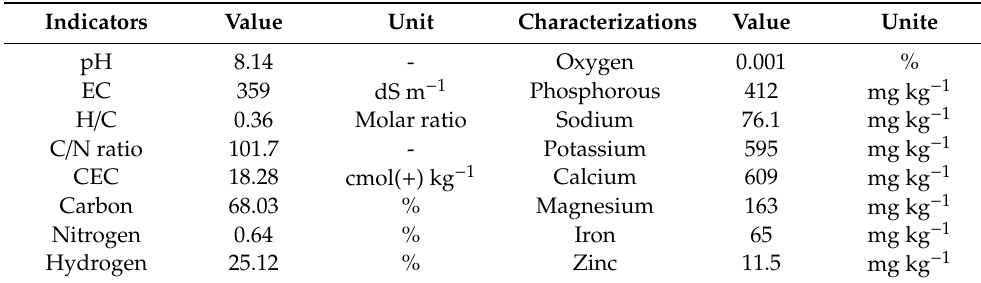
Table 3. Characteristics of rice husk